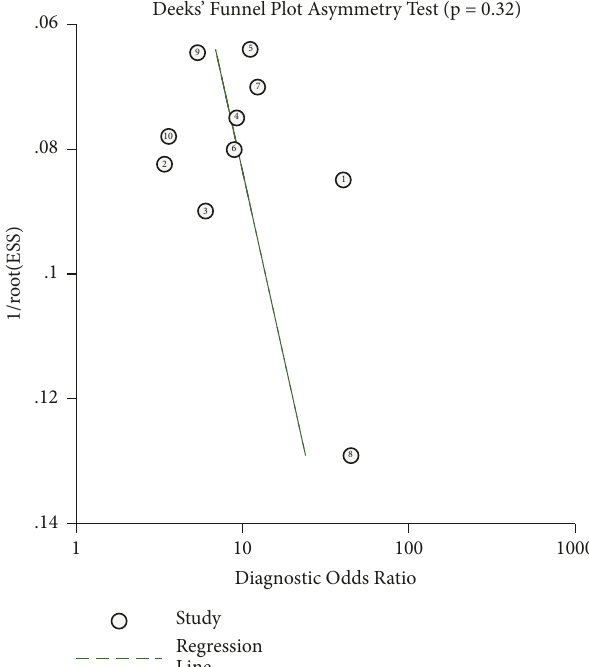
Figure 4: Deek’s funnel plot to evaluate the publication bias of test accuracy.